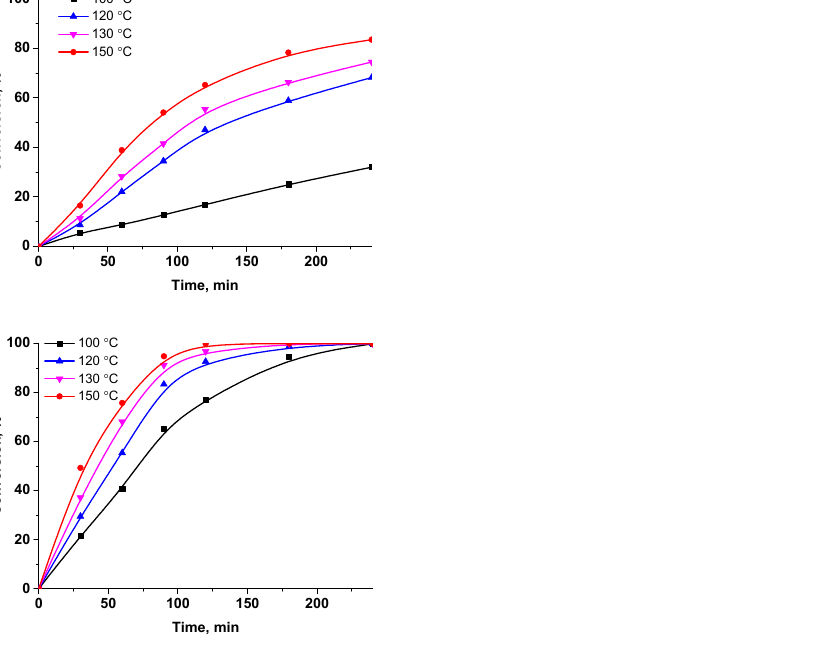
Figure 7. The effect of temperature on the hydrogenation of LA to GVL in the presence of Ru-PPP ( a ) and Ru-PPP-S ( b ) in the range of temperatures and under constant H 2 pressure of 2 MPa. Reaction conditions: LA 1 g, solvent (H 2 O) 50 mL, catalyst loading 0.064 mol.% of Ru for Ru-PPP and 0.016 mol.% for Ru-PPP-S. The effect of pressure was also investigated using 2, 3 and 5 MPa of H 2 (Figure 8). A similar trend was observed: the pressure increase leads to the increase in conversion.